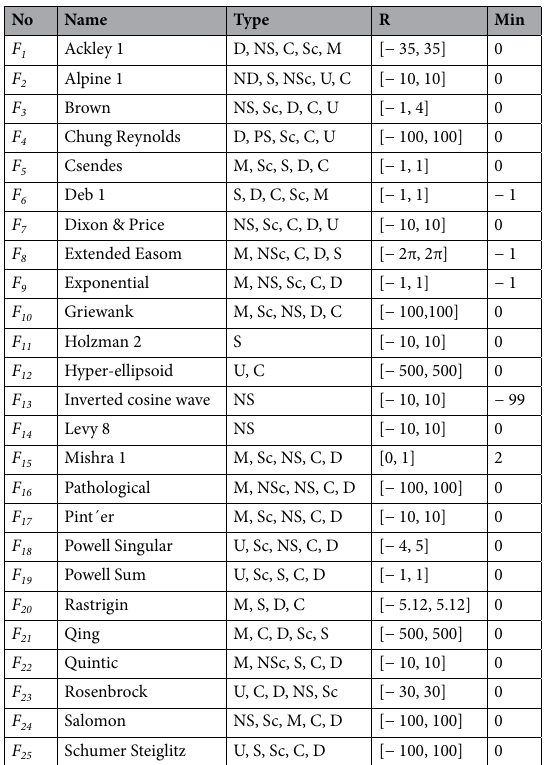
Table 1. The mathematical test functions used in this study possess certain fundamental characteristics.